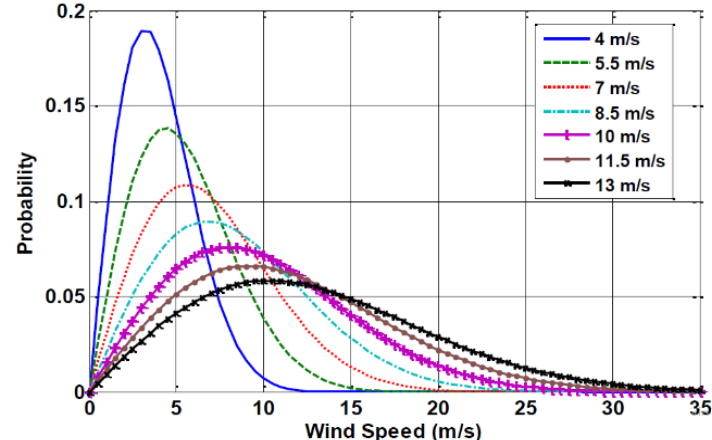
Figure 1. Rayleigh distribution for different mean wind speeds